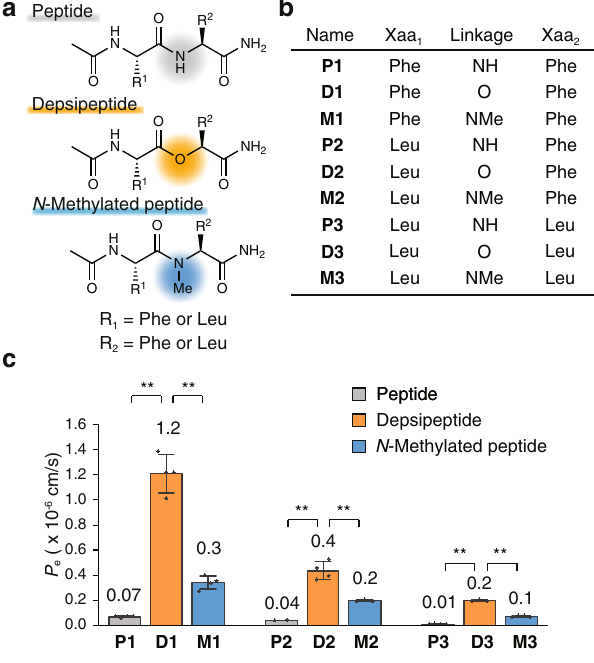
Fig. 1 | The effect of amide-to-ester substitution on the permeability of dipeptides. a Generalstructures of modeldipeptides. b Sequences of synthesized dipeptides. c Permeability values of the synthesized dipeptides measured by PAMPA. PAMPA was conducted with 10 μ M compounds in 5% DMSO/PBS (pH 7.4) and18hincubationat25°C.Eachbarrepresentsthemeanvalue,andtheerrorbars the standard deviation from experiments carried out in quadruplicate. For P2 , the peptides from the acceptor wells in two out of four trials were under the quanti- fi cation limit, therefore the bar represents the mean value, and the error bars the standard deviation from experiments carried out in duplicate. P values were determinedbyatwo-sidedWelch ’ s t -test.** p <0.01. p ( P1 vs. D1 )=0.0007, p ( D1 vs. M1 )=0.0007, p ( P2 vs. D2 )=0.0017, p ( D2 vs. M2 )=0.0072, p ( P3 vs. D3 )<0.0001 and p ( D3 vs. M3